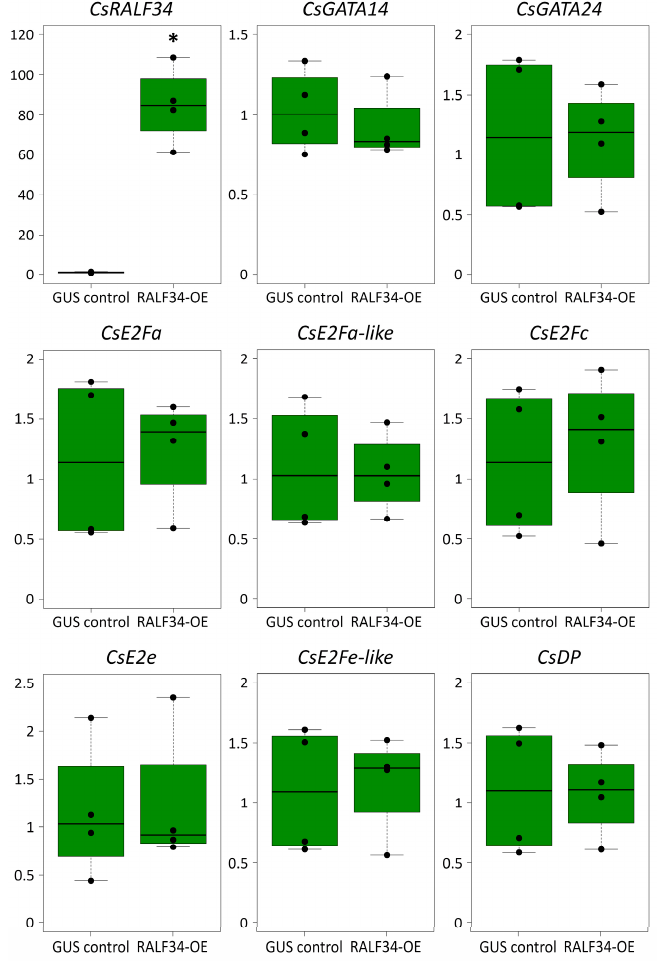
Figure 4. Relative transcript levels of Cucumis sativus RALF34 , GATA14 , GATA24 , and E2F/DP genes in control roots and in roots overexpressing CsRALF34 . GUS control, transgenic roots expressing GUS ; RALF34-OE, transgenic roots overexpressing CsRALF34 . Statistical analysis using Wilcoxon’s signed- rank test showed significant differences (*, p < 0.05) between expression levels in the overexpression group compared with the control only for CsRALF34 (asterisk). The y -axis indicates relative transcript levels (2 − ∆∆ CT